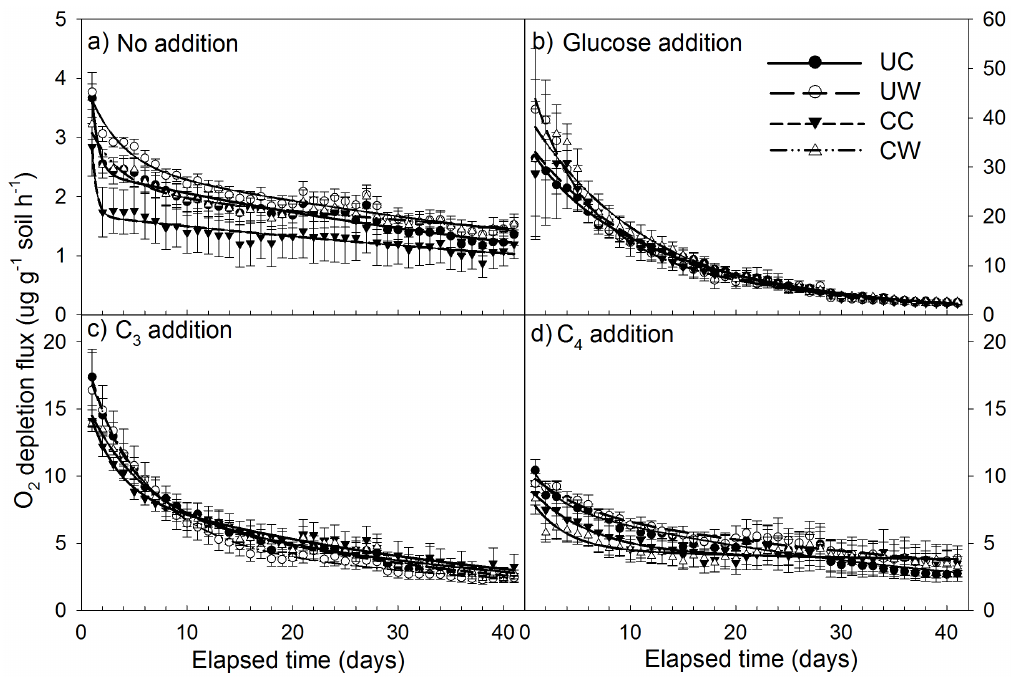
Figure 1. Soil respiratory carbon (C) release represented by O 2 depletion flux without additional substrate (a) and with the addition of glucose (b), C 3 (c), and C 4 (d) substrate under the four treatments: UC: unclipped control; UW: unclipped and warmed; CC: clipped control; CW: clipped and warmed.